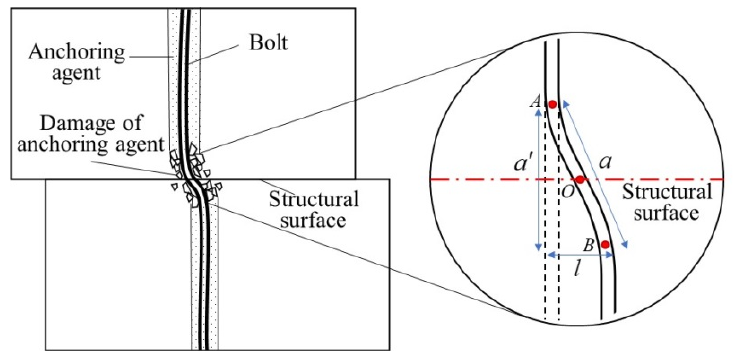
Figure 13. Schematic diagram of rock bolt deformation at structural surface .